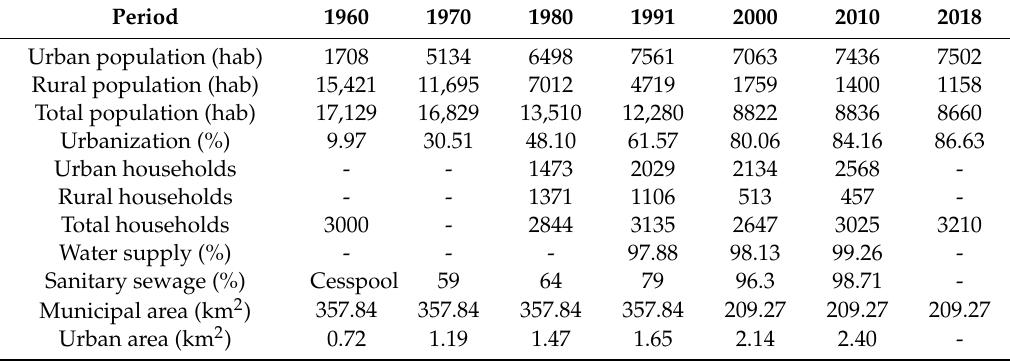
Table 3. Evolution of land use and occupation, with estimated demographic density values for Ur â nia [26].